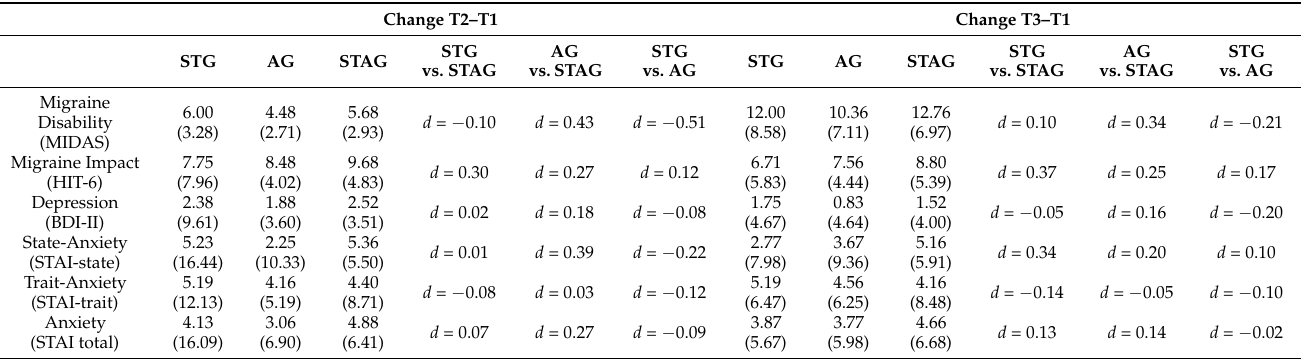
Table 2. Comparison of the changes observed between the three intervention groups in migraine disability and impact, and levels of depression and